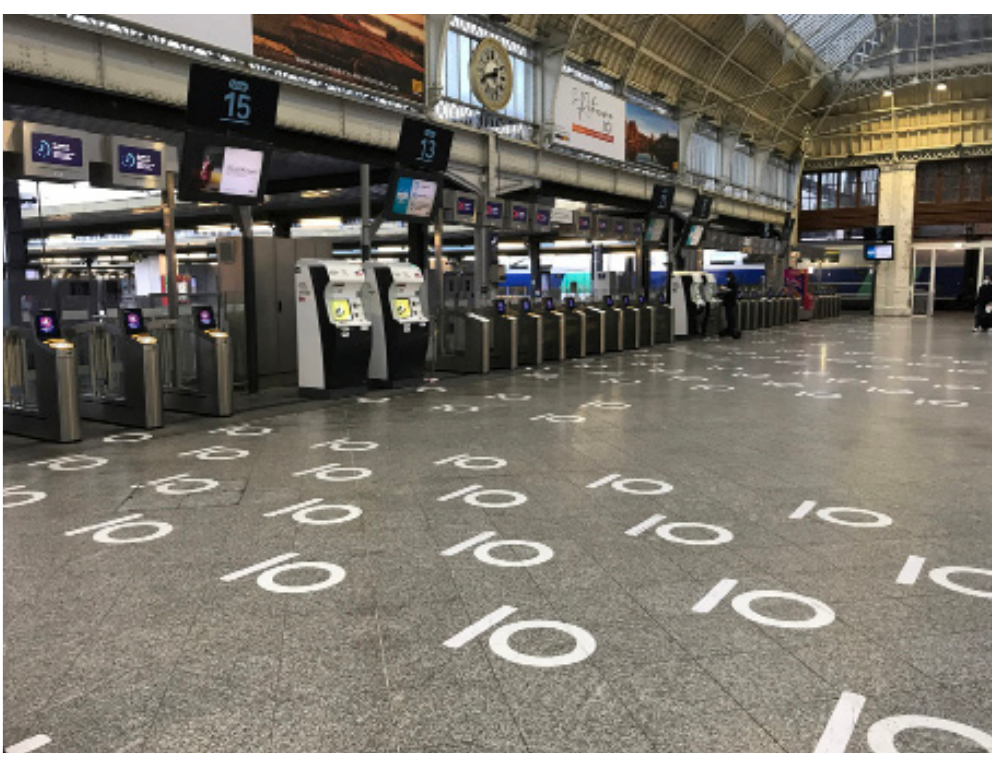
Fig. 8 Gare de Lyon, Paris (photos from the